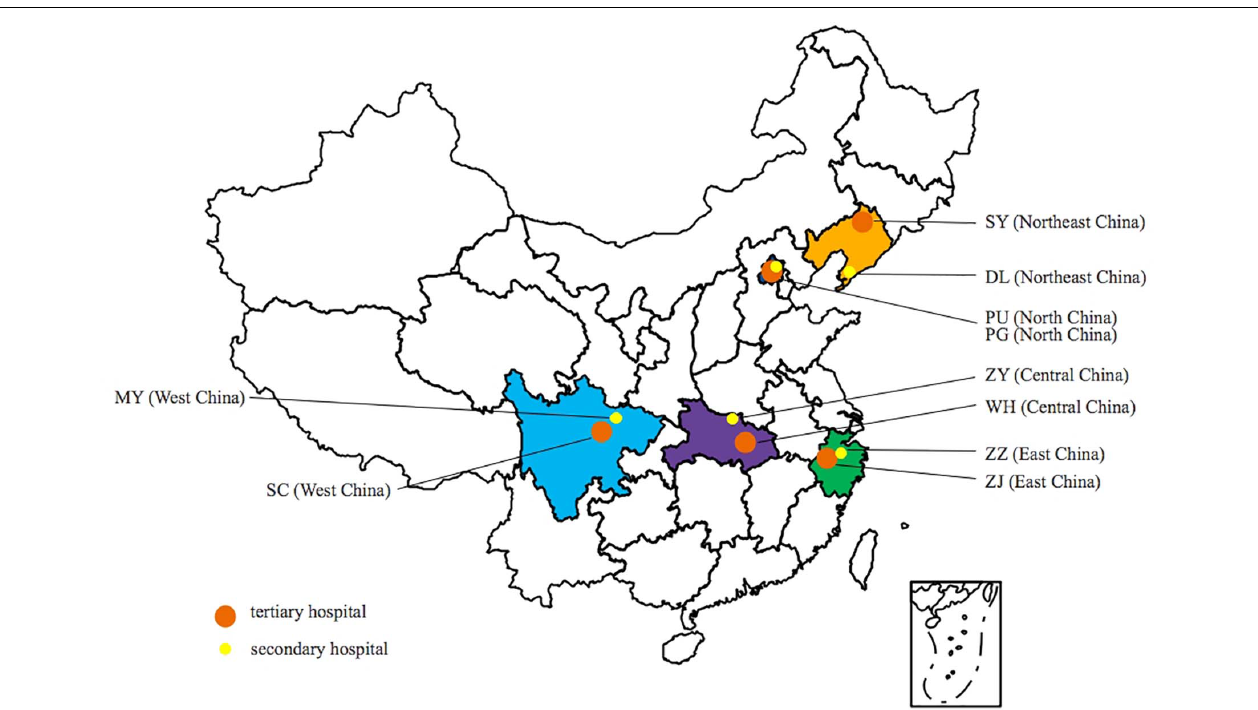
FIGURE 1 | Geographical distribution of hospitals participating in the study. PU, Peking Union Medical College Hospital; PG, Beijing Pinggu Hospital; SY, Shengjing Hospital of China Medical University; DL, Dalian Hospital; ZZ, Zhuji People’s Hospital of Zhejiang Province; ZJ, The First Affiliated Hospital College of Medical Zhejiang University; WH, Tongji Hospital; ZY, First Peoples Hospital of Zaoyang; SC, Sichuan Provincial People’s Hospital; and MY, Sichuan Science City